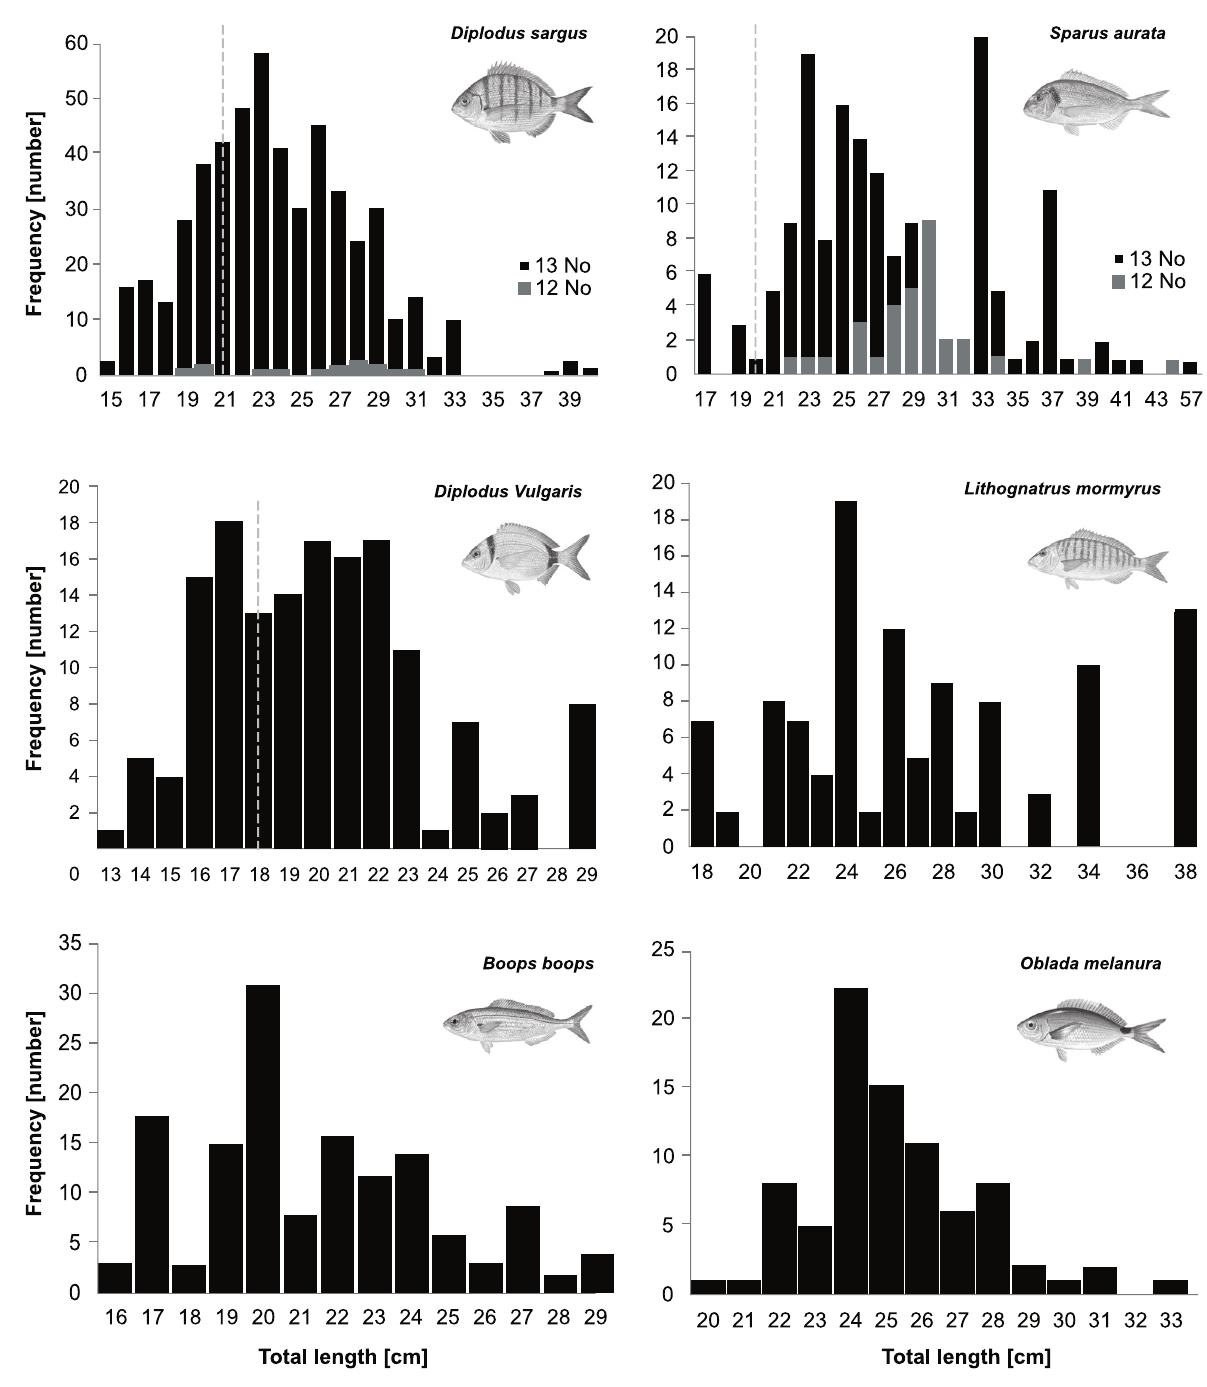
Fig. 2. The size distribution of the six most abundant species ( Diplodus sargus , Sparus aurata , Diplodus vulgaris , Boops boops , Lithognathus mormyrus , and Oblada melanura ); Dashed lines indicate the minimum landing size values of